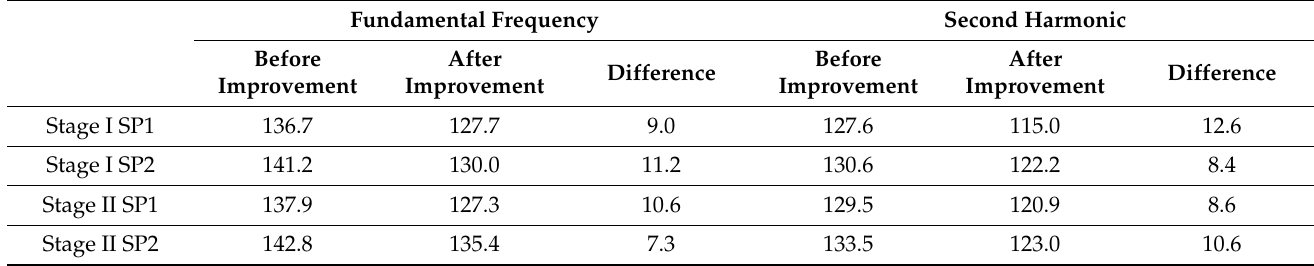
Table 9. Noise at rotating fundamental frequency and second harmonic at rated condition